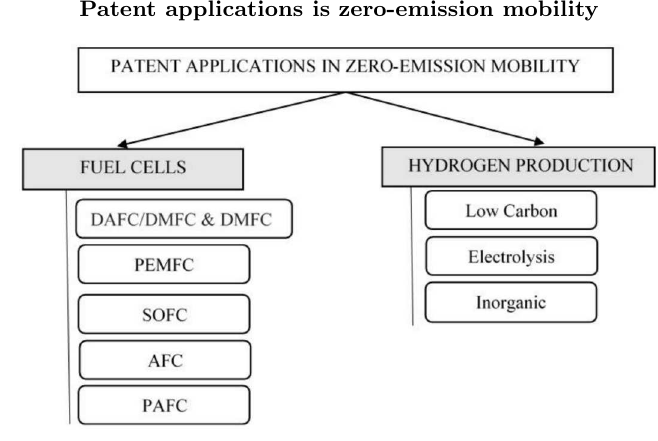
Source: own elaboration based on FCHO Fuel Cells & Hydrogen Observatory,